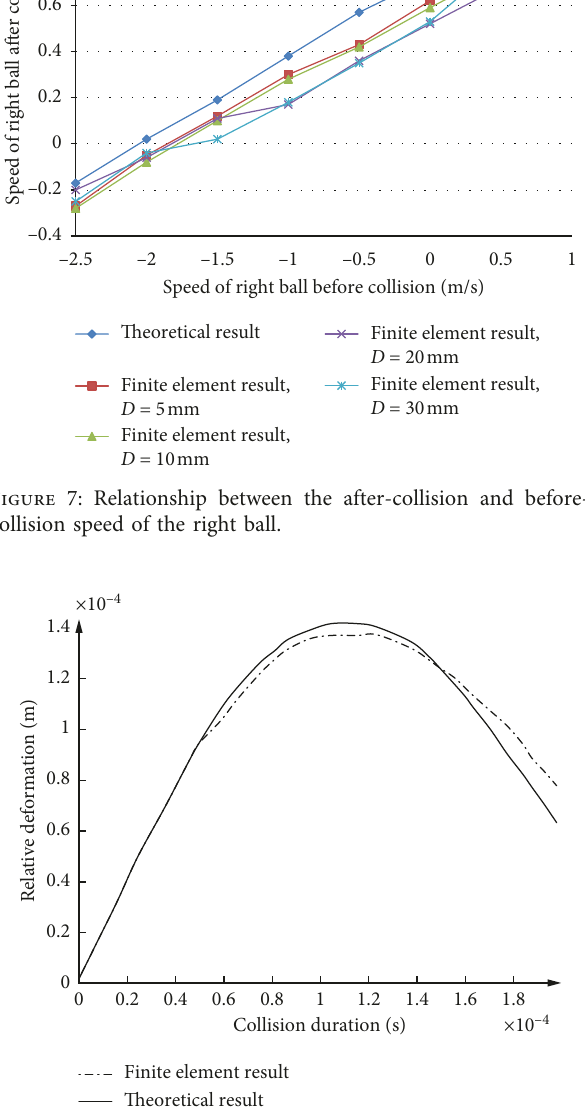
Figure 8: Curve of collision duration-relative deformation (tan- gential velocity of two balls is 0m/s).